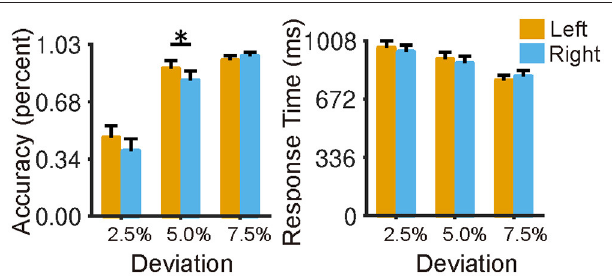
FIGURE 2 | Behavioral performance of the landmark task in terms of reaction time and accuracy. Participants showed a slight leftward bias in the landmark condition (2.5, 5, 7.5% indicate the bias degree to the midpoint of the horizontal line), and no speed-accuracy trade-off was observed. The error bar represents a 95% confidence interval. * p < 0.05, ** p < 0.01, *** p < 0.001.